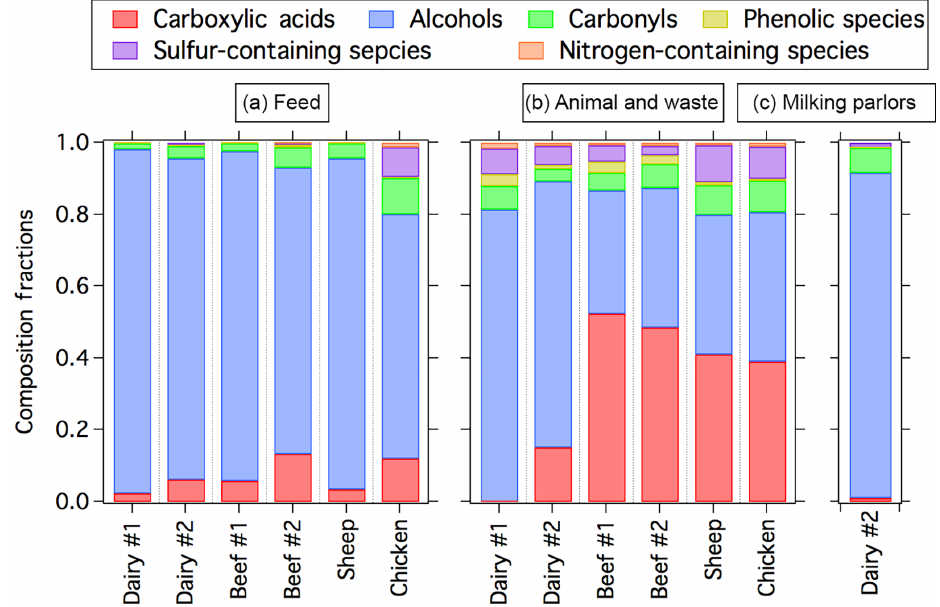
Figure 5. The relative contributions of each VOC class to emissions from feed storage + handling (a) , animal + waste (b) and milking par- lors (c)